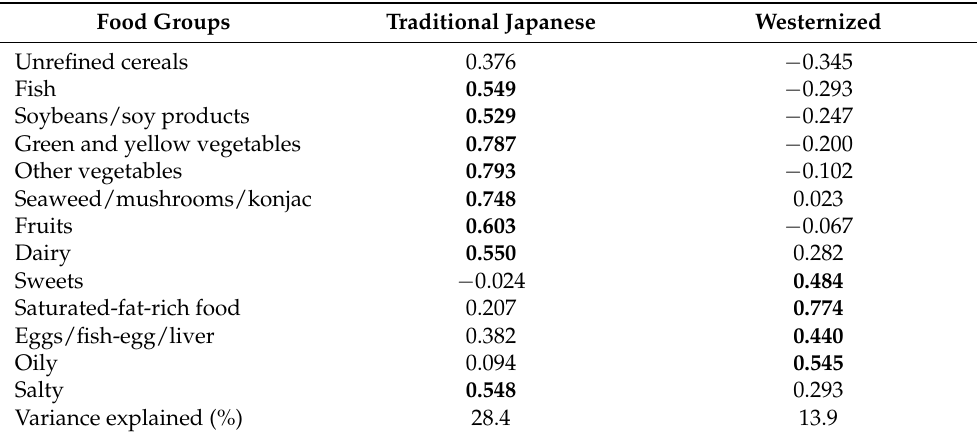
twice/week: (1), 2 to 7 times/week: (2), 8 to 13 times/week: (3), 14 to 18 times/week: (4), 19 or more times/week: (5). Table 2. Factor loadings and explained variations for the dietary patterns identified by principal component